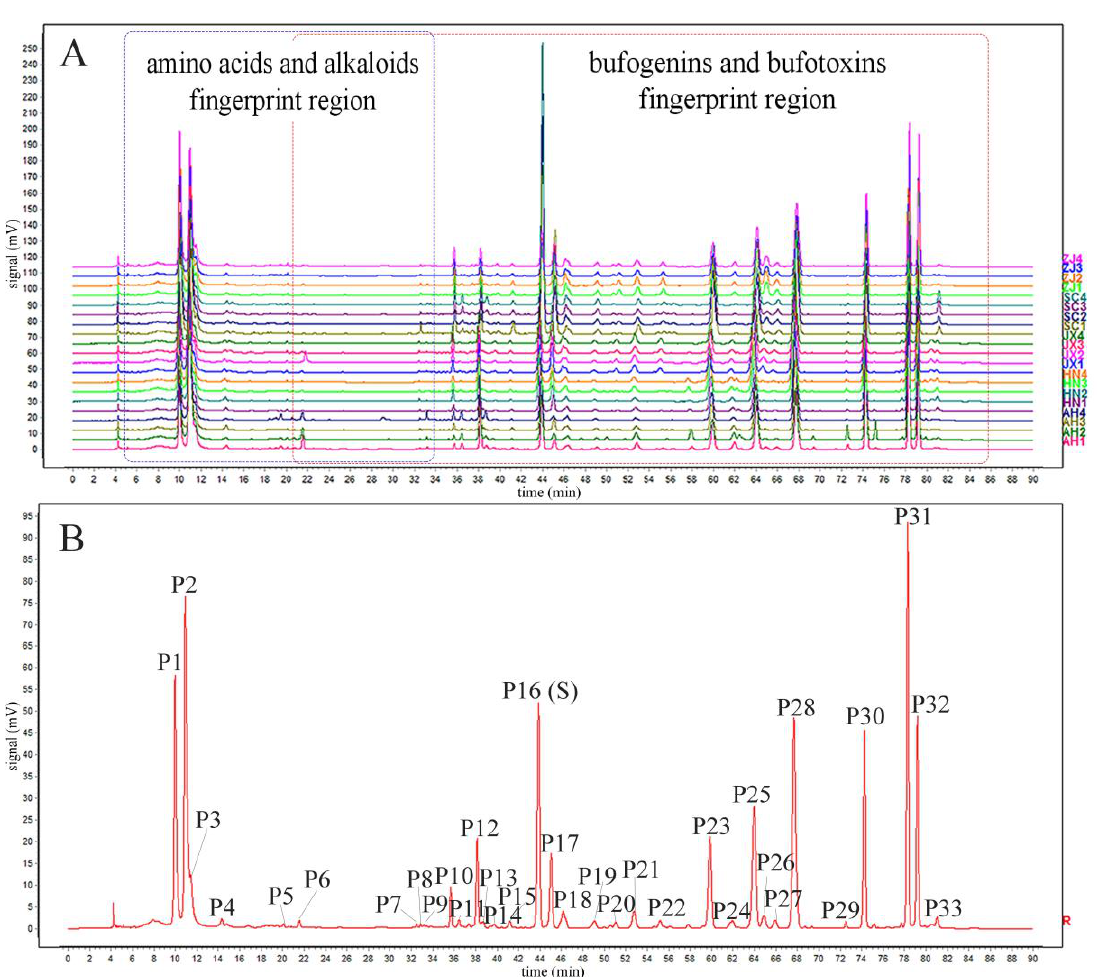
Figure 6. HPLC fingerprints ( A ) and reference fingerprint ( B ) of 20 Chansu samples. P1, serotonin ( 13